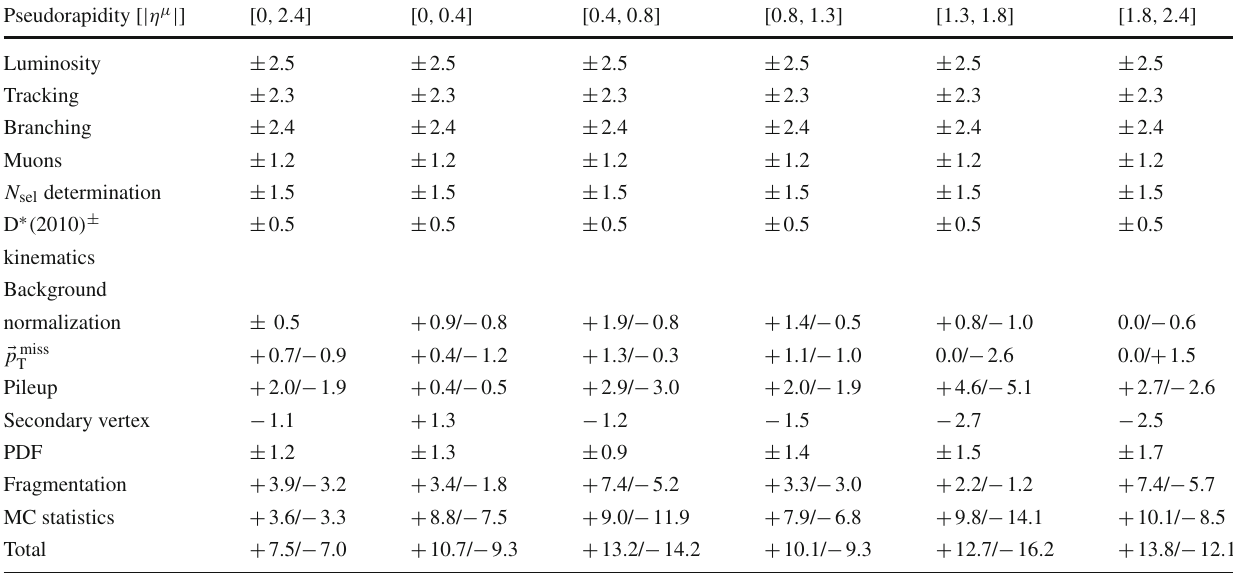
Table 1 Systematic uncertainties [%] in the inclusive and differential W + c cross section measurement in the fiducial region of the analysis. The total uncertainty corresponds to the sum of the individual contribu- Pseudorapidity [| η μ